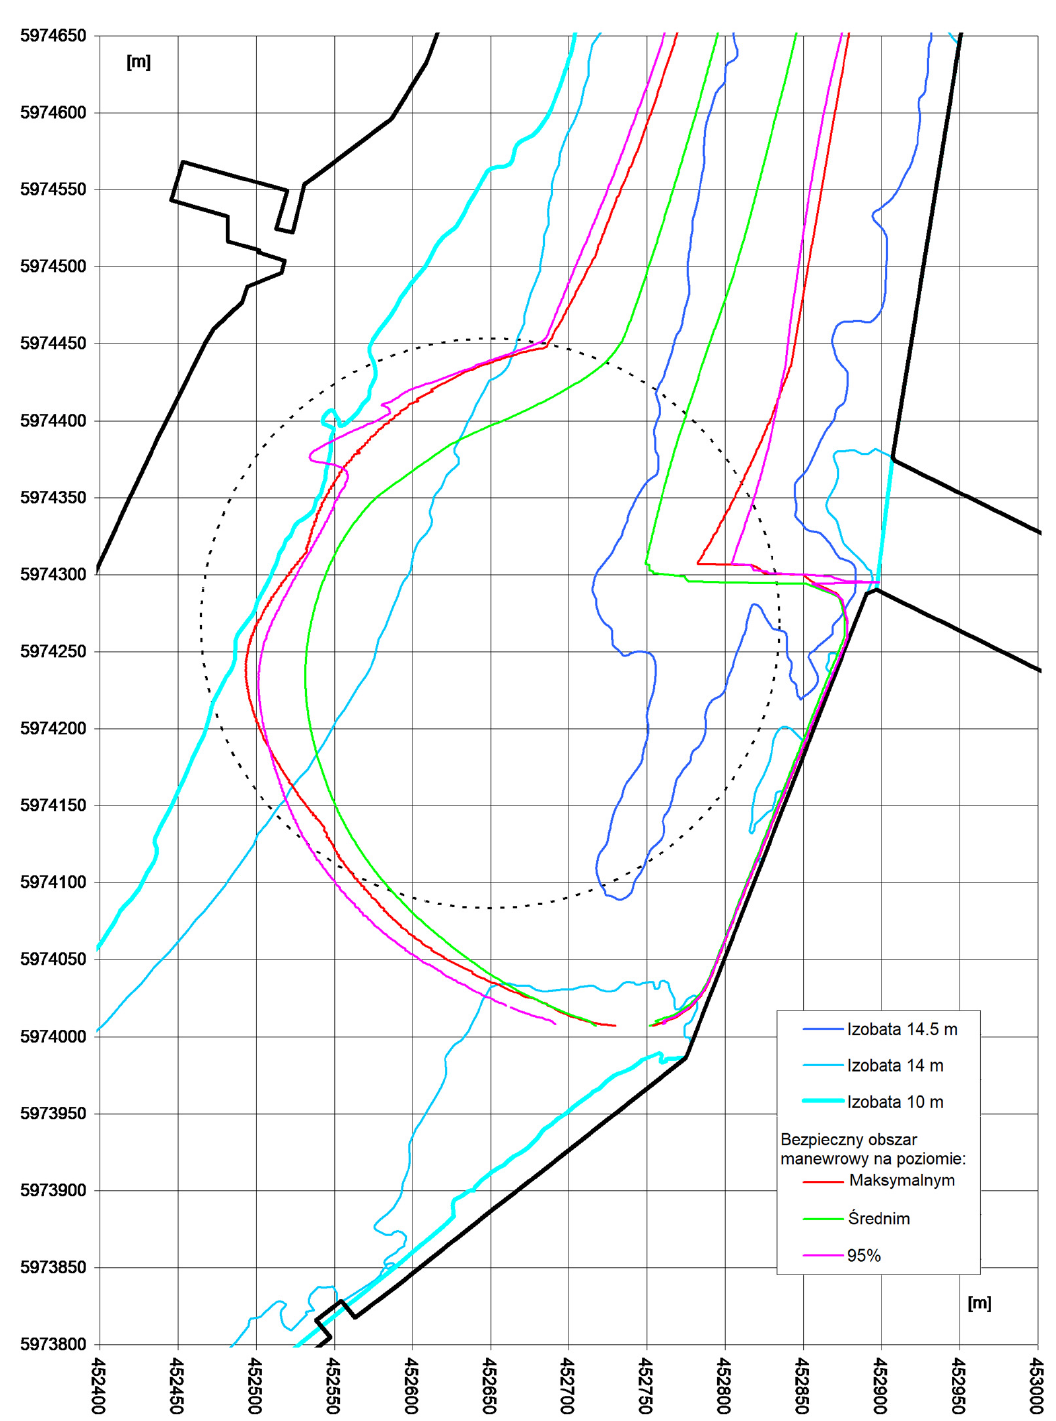
Figure 4. Safe maneuvering areas of turning in the Northern Turning Basin in Ś winouj ś cie, bulk carrier under ballast L c = 300 m, T D = 7.4 m, T R = 9.0 m/s, ingoing current 0.8 knots, UTM coordinates (zone 33U).